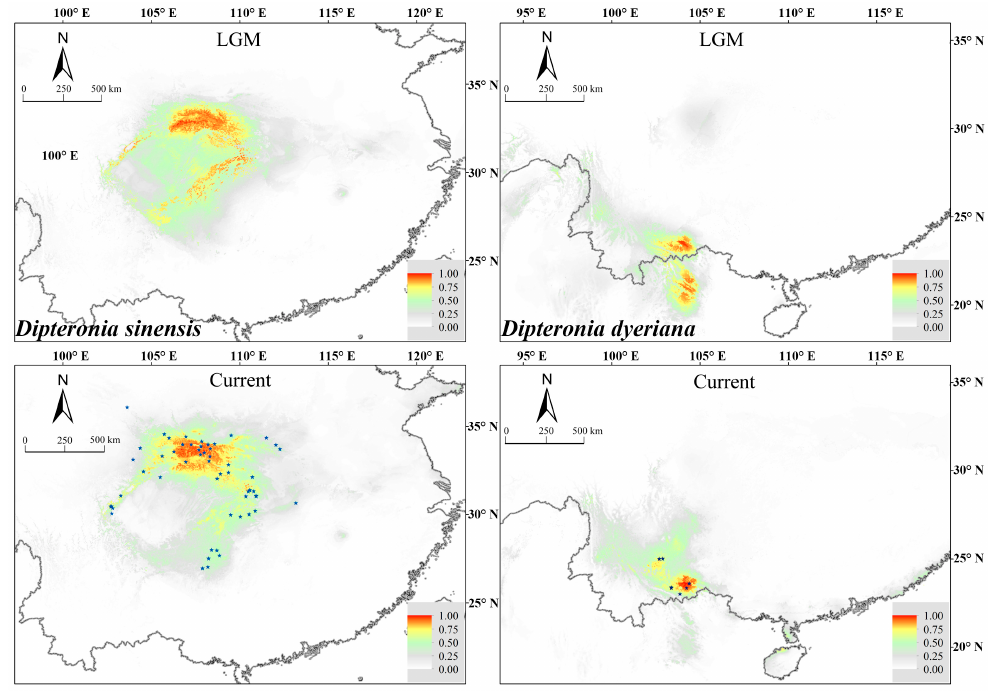
Figure 6. Potential distribution of D. sinensis and D. dyeriana based on ecological niche modeling using MAXENT; as well as the predicted distribution of the model to the last glacial maximum ( c. 21 kya) and present. The color gradient from white to the red refers to habitat suitability from low to high.